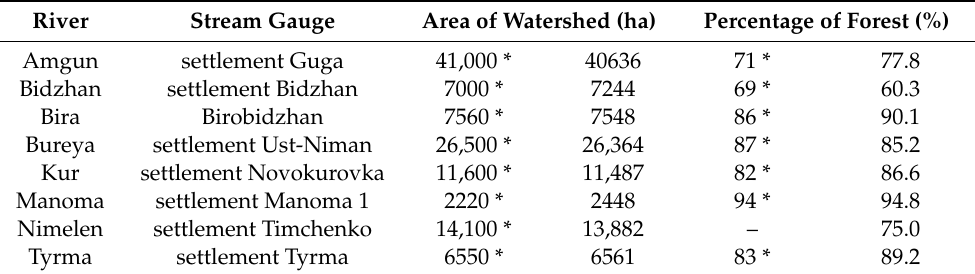
Table 3. The area and forest coverage of watersheds of the Middle and Lower Amur. River Stream Gauge Area of Watershed